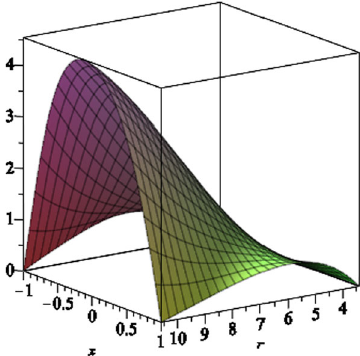
Fig. 5 The scaled function S ( r , x ) versus r − ≤ r ≤ r H and − 1 ≤ x ≤ 1, where we set the black hole parameters a = 6 , b = 2 , l = 1 , m = 7 and q = 1